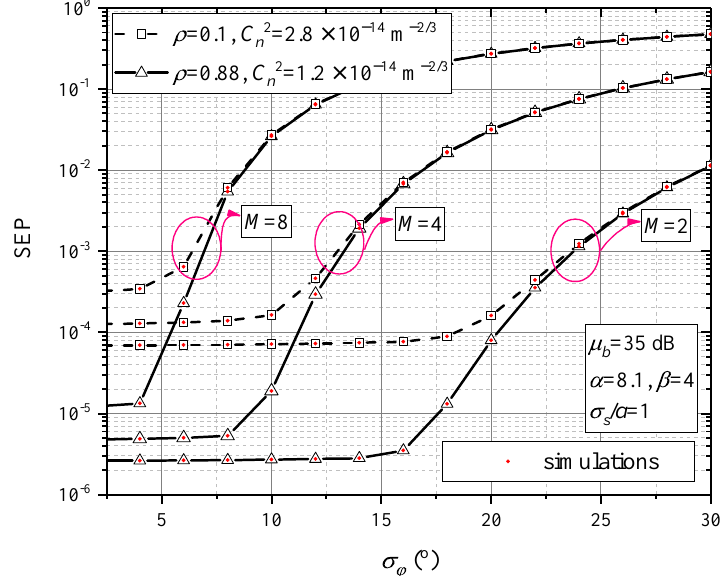
Figure 5. Average SEP vs. standard deviation of the phase